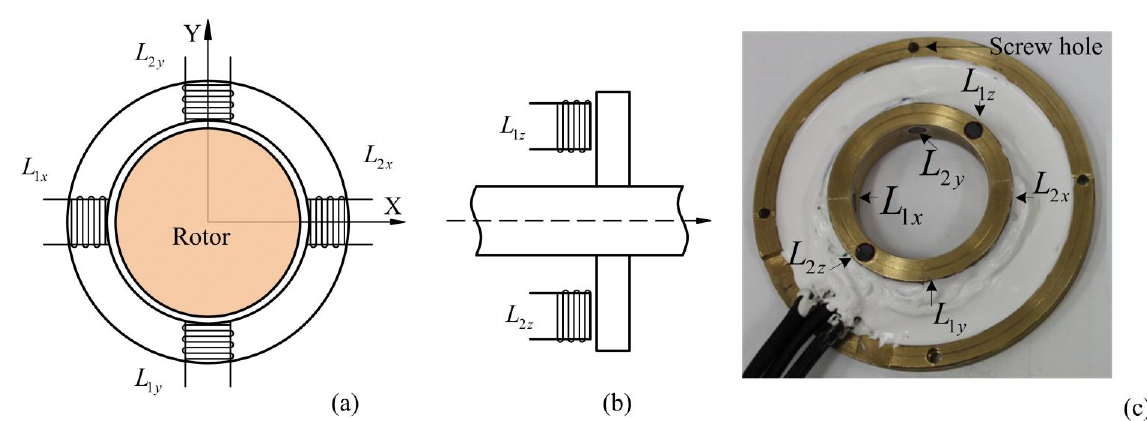
Figure 8. Inductive sensor head position, ( a ) radial sensors; ( b ) axial sensors; ( c ) experimental setup.